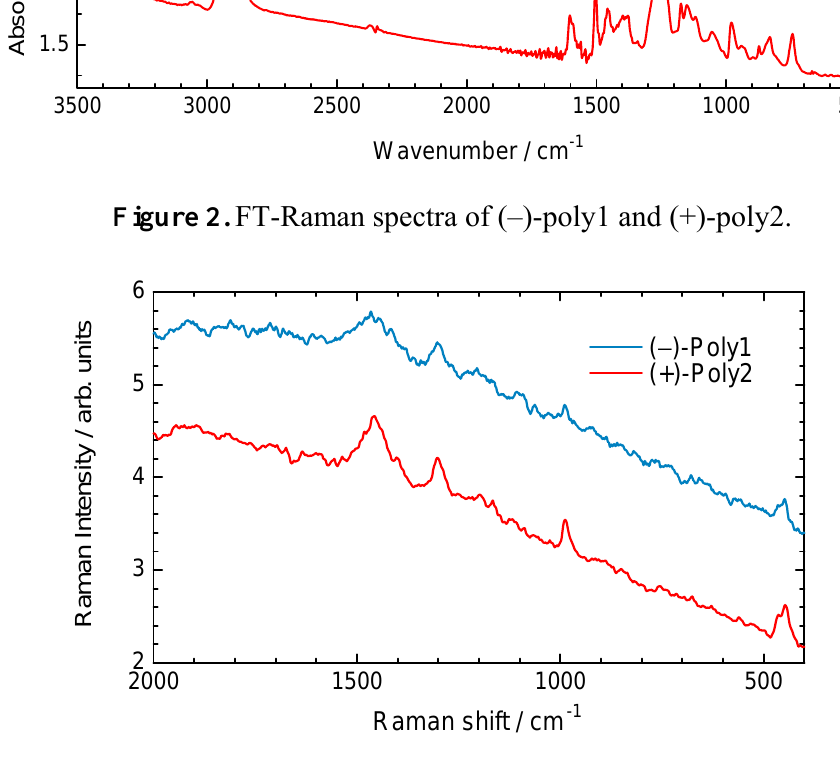
Figure 2. FT-Raman spectra of (–)-poly1 and